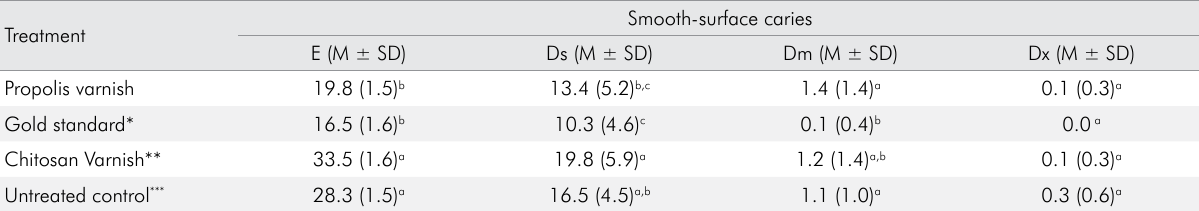
Table 2. Effects of the treatment with the experimental propolis varnish on the development and severity of smooth-surface caries in rats. The values of the of the caries scores are given as mean ± standard deviation using the Keyes’ classification modified by Larson.